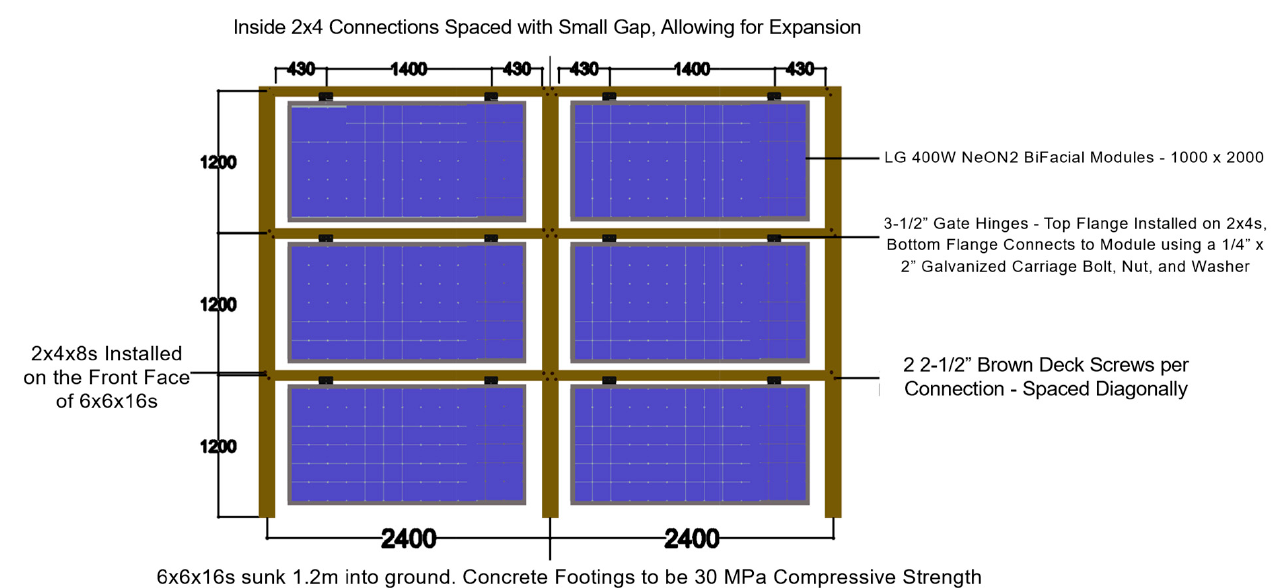
Figure 5. Completed 2-section system. The installation process can be continued for systems with more than two sections.